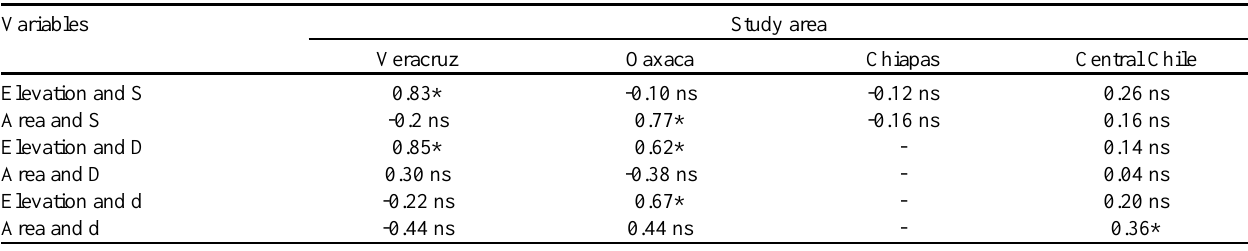
Table 3 . Pearson correlation coefficients (r) between elevation and patch area and tree species richness (S), density (D) and seedling densities (d). Correlations with p < 0.05 are indicated with *, p < 0.01 indicated with **, ns = non-significant. Analyses were not conducted in southern Argentina because of the very low species richness values encountered. Source: Newton and Tejedor (2011). Variables Study area Veracruz Oaxaca Chiapas Central Chile Elevation and S 0.83* -0.10 ns -0.12 ns 0.26 ns Area and S -0.2 ns 0.77* -0.16 ns 0.16 ns Elevation and D 0.85* 0.62* - 0.14 ns Area and D 0.30 ns -0.38 ns 0.04 ns Elevation and d -0.22 ns 0.67* 0.20 ns Area and d -0.44 ns 0.44 ns